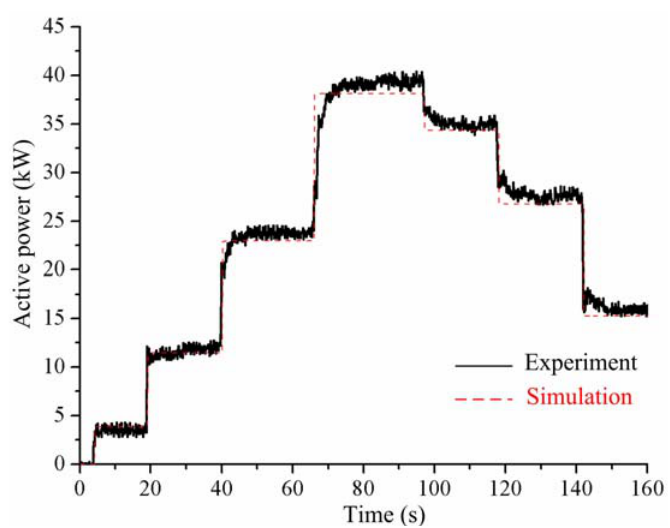
Figure 11. Active power responses of the HESGS under varied load power step.